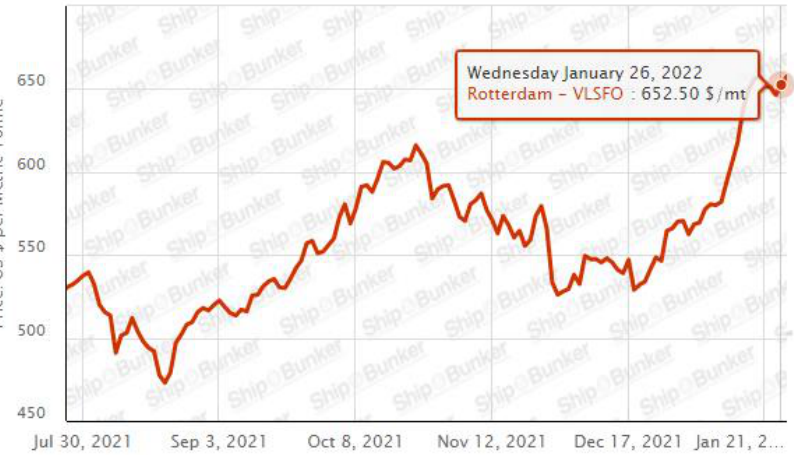
Figure 1. View of price evolution for VLSFO. Source: shipandbunkers.com (accessed on 14 March 2022).